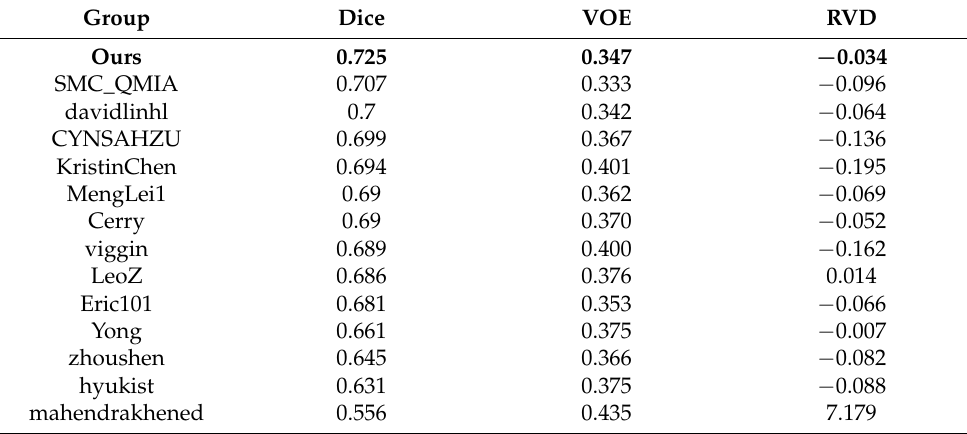
Table 8. Comparison of liver tumor